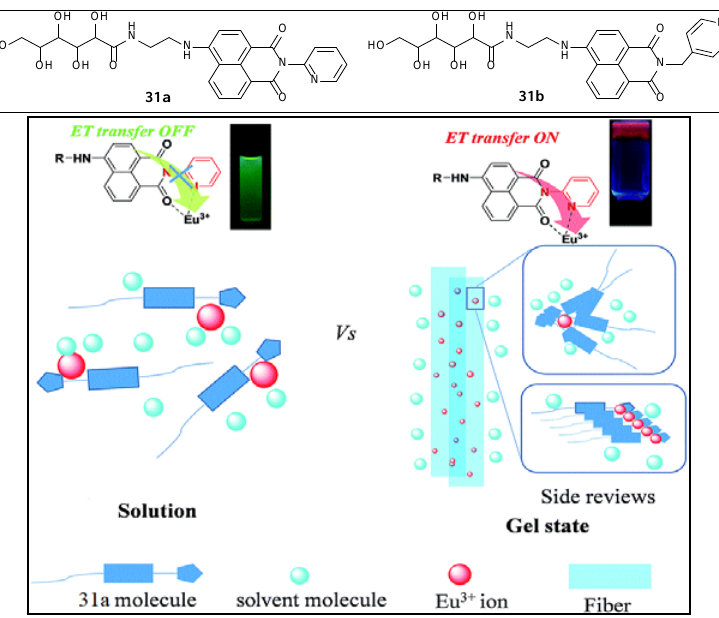
Figure 19. Illustration of the assembly mechanism and energy transfer process of 31a and Eu 3+ ions. Reprinted with permission from [84]. Copyright 2015 Royal Society of Chemistry.